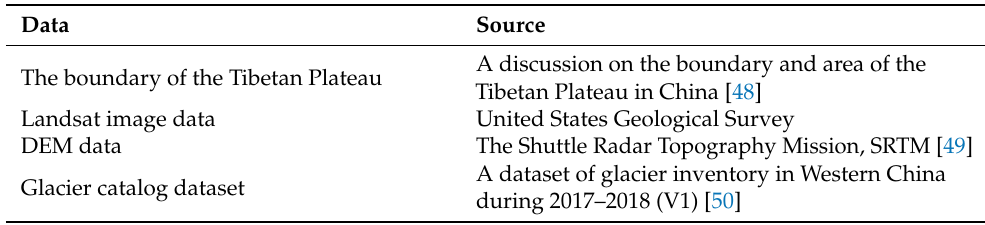
Table 1. The data and sources used in the